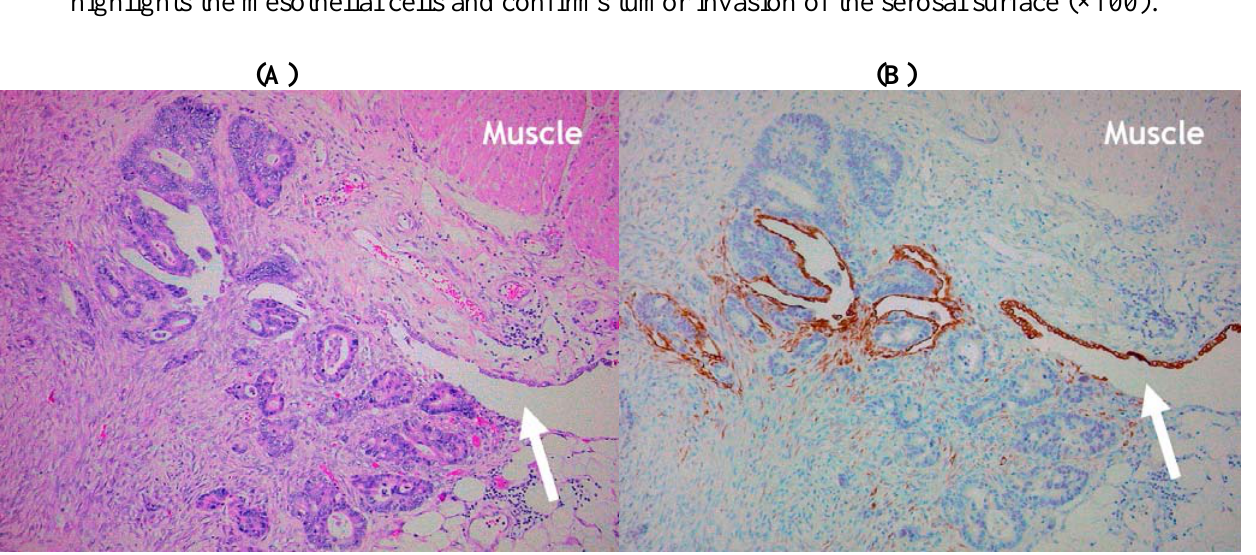
Figure 7. Histological image of colorectal carcinoma with serosal invasion on the anti-mesenteric border. ( A ) Note proximity of the muscle (muscularis propria, upper right field) to the serosal surface (arrow) (×100). ( B ) Immunohistochemistry for cytokeratin 7 highlights the mesothelial cells and confirms tumor invasion of the serosal surface